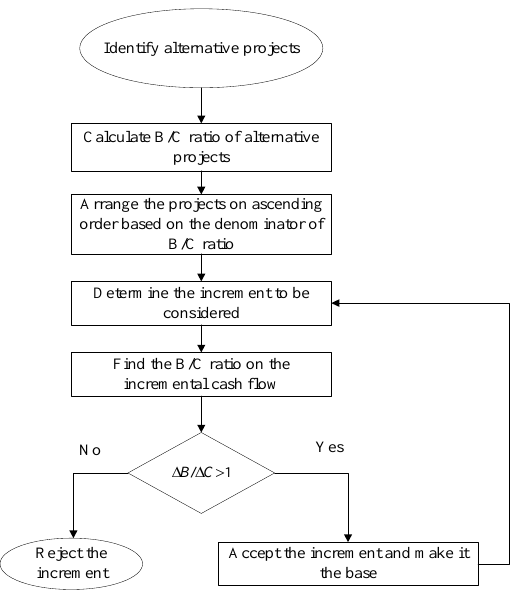
Figure 8. Incremental benefit to cost ratio analysis.